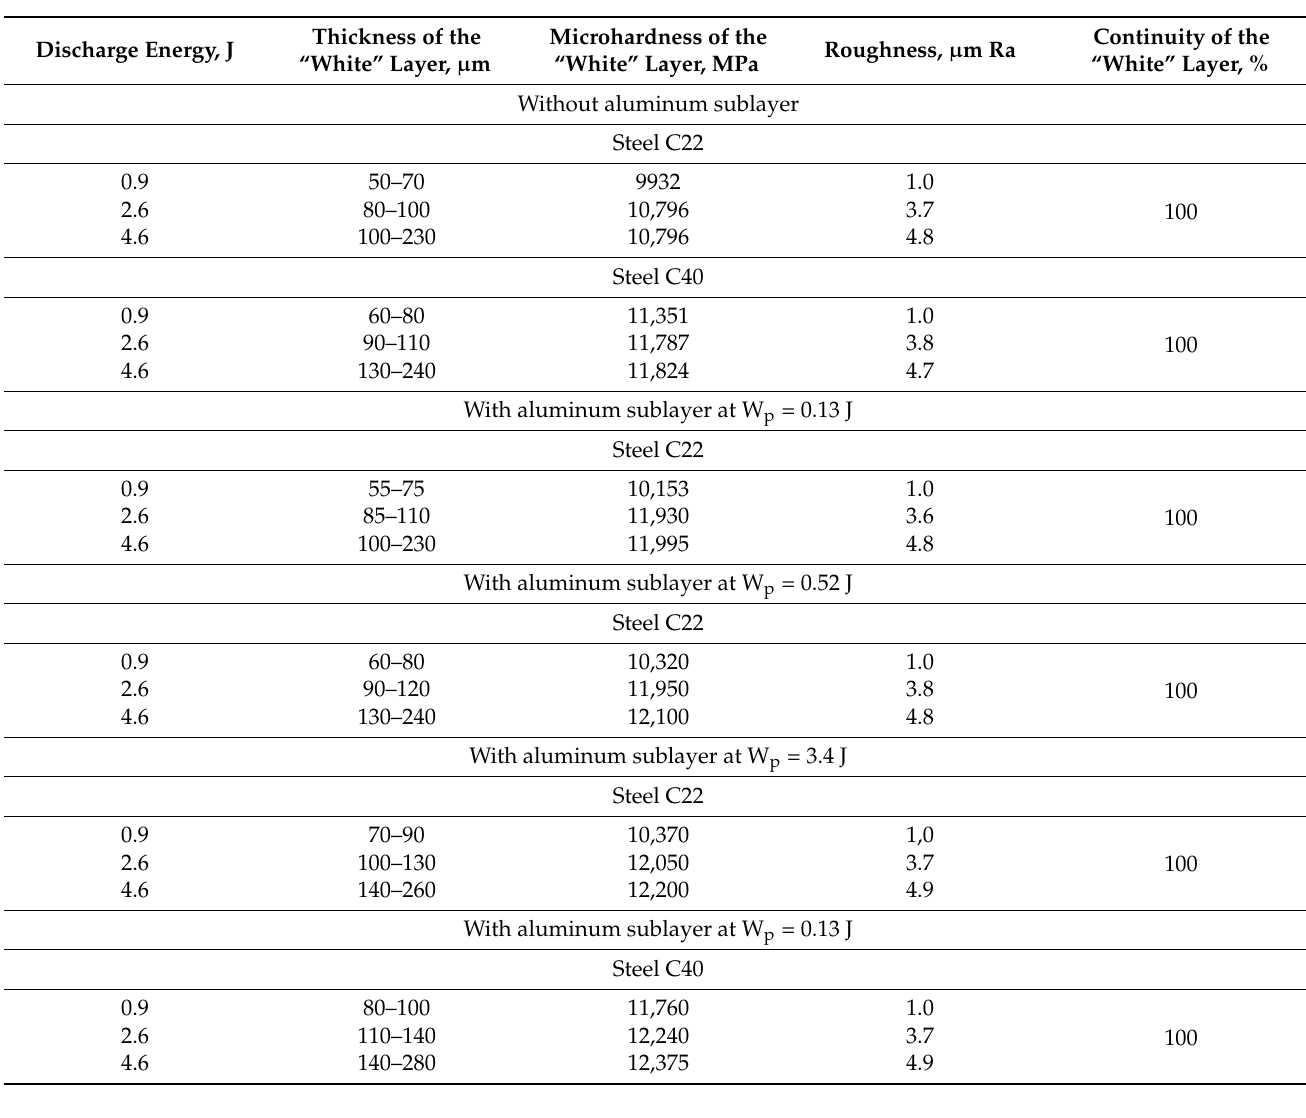
Table 3. The qualitative CESA parameters obtained on steel C22 and steel